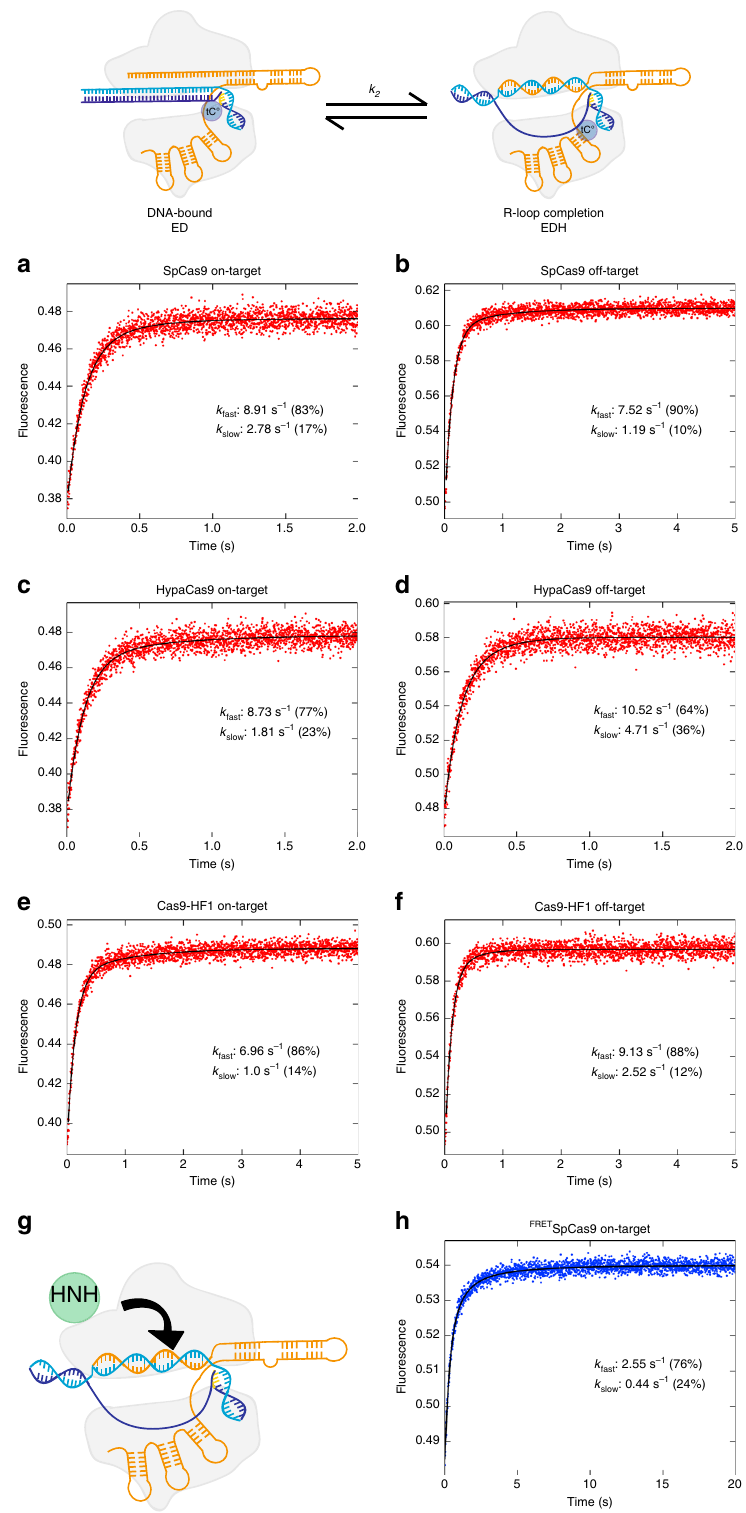
Fig. 3 DNA unwinding occurs more rapidly near the PAM. R-loop formation decay rates were measured by the monitoring the fl uorescence increase from tC o (position − 1 in the non-target strand) as a function of time after mixing enzyme (28 nM) with DNA (10 nM) in the presence of 10 mM Mg 2 + . Data were fi t to a double exponential function to get the decay rates shown. a, b SpCas9 (28 nm) with on-target ( a ) and off-target ( b ) DNA, c, d HypaCas9 with on-target ( c ) and off-target ( d ) DNA. e, f Cas9-HF1 with on-target ( e ) and off-target ( f ) DNA. g Cartoon of the HNH domain rearrangement. h The FRET SpCas9 labeled with Cy3 and Cy5 pair at C867 and C355, respectively, was used to measure the HNH domain motion during cleavage of on-target